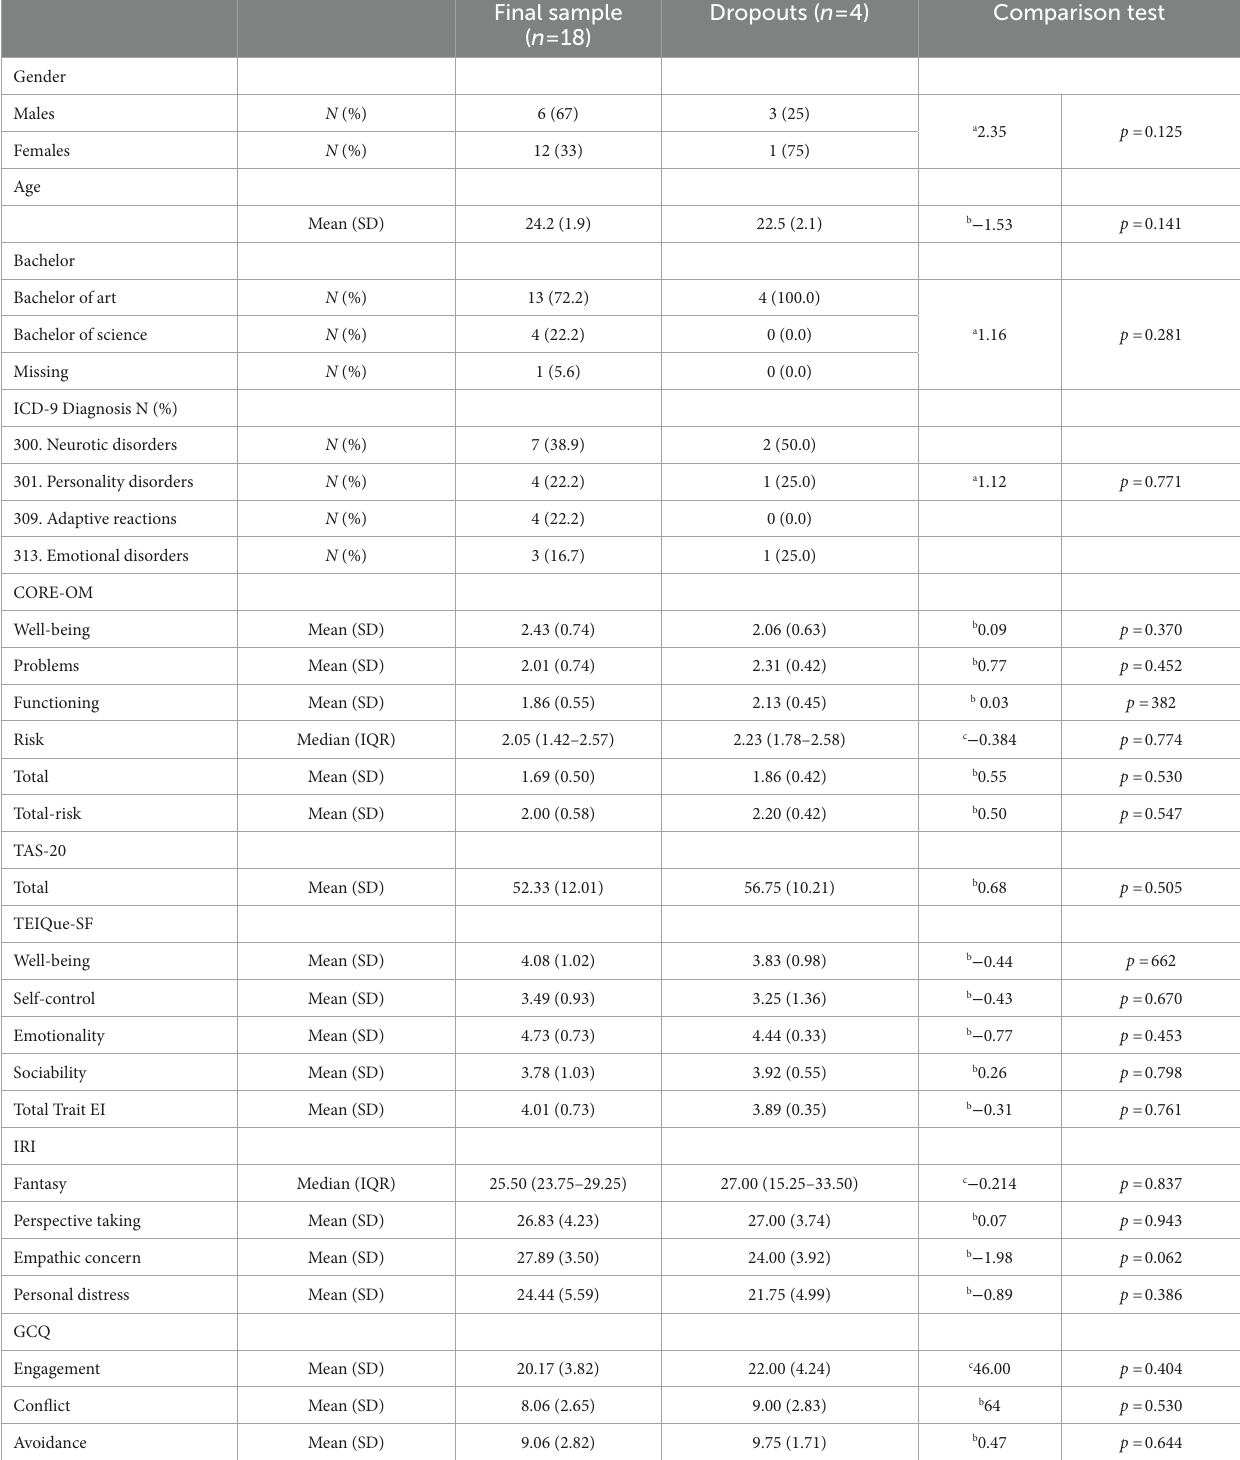
TABLE 1 Comparison between completers and